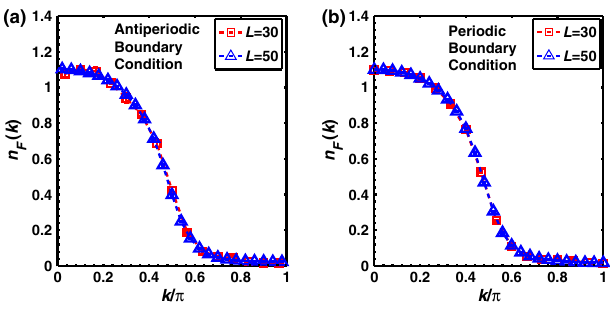
k Þ at β ¼ 10 , FIG. 15. The momentum space occupation n F ð V ¼ 0 , J ¼ 2 , and n ¼ 1 . Results of n k Þ for both the (a) anti- F ð periodical boundary condition and (b) periodical boundary condition are presented at two different sizes of L ¼ 30 and